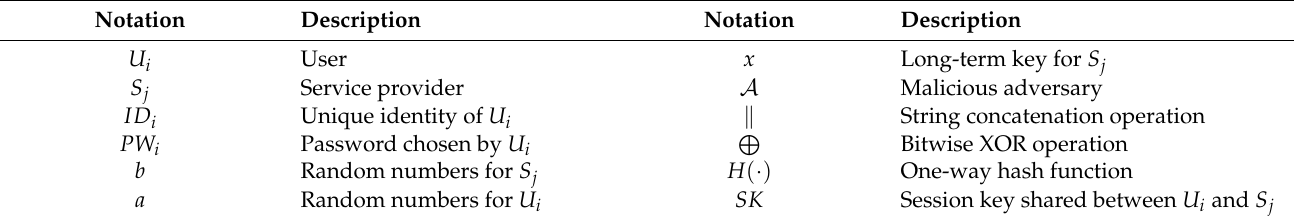
Table 2. Notations with related descriptions.